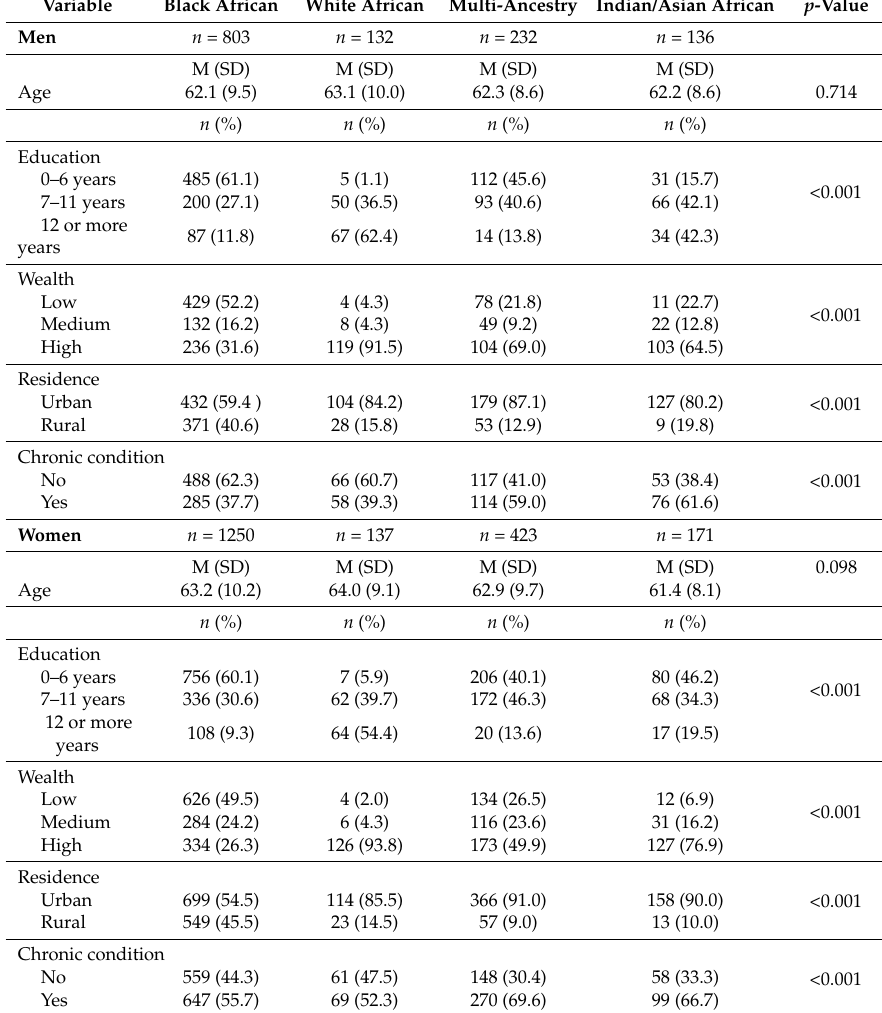
Table 1. Sample characteristics by population group and gender ( N =